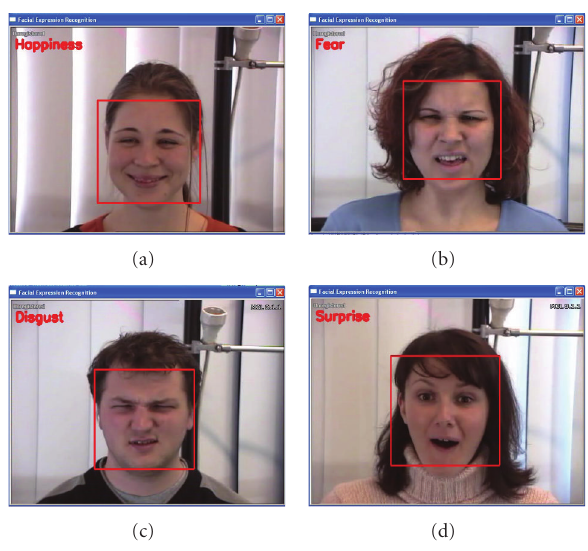
Figure 6: Recognition samples from FG-NET.